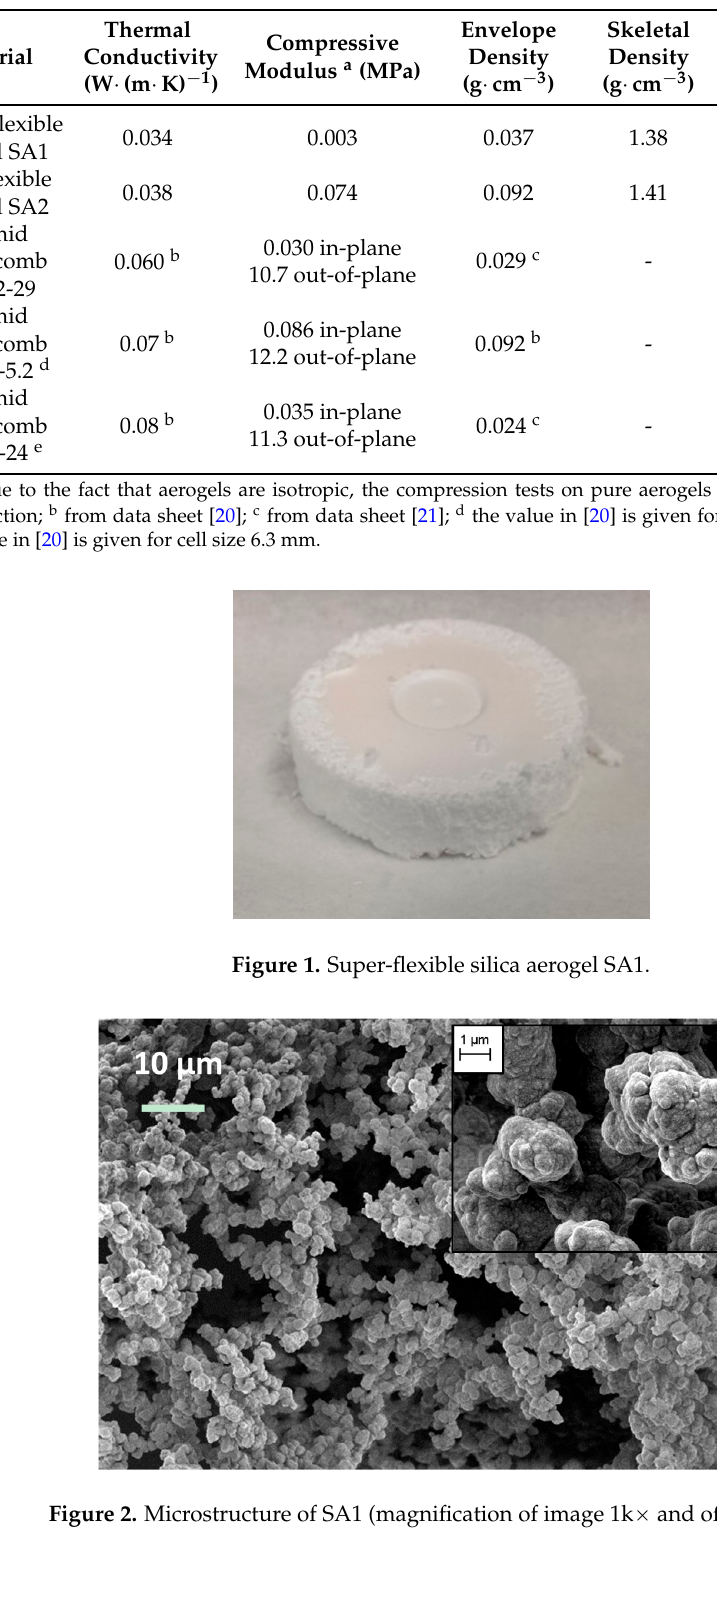
Table 1. Properties of produced aerogels and honeycombs.